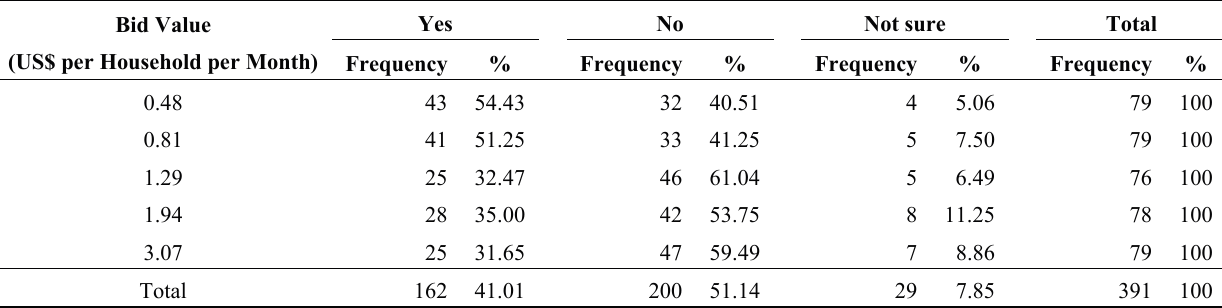
Table 2. Respondent acceptance of different household kitchen waste separation (HKWS)